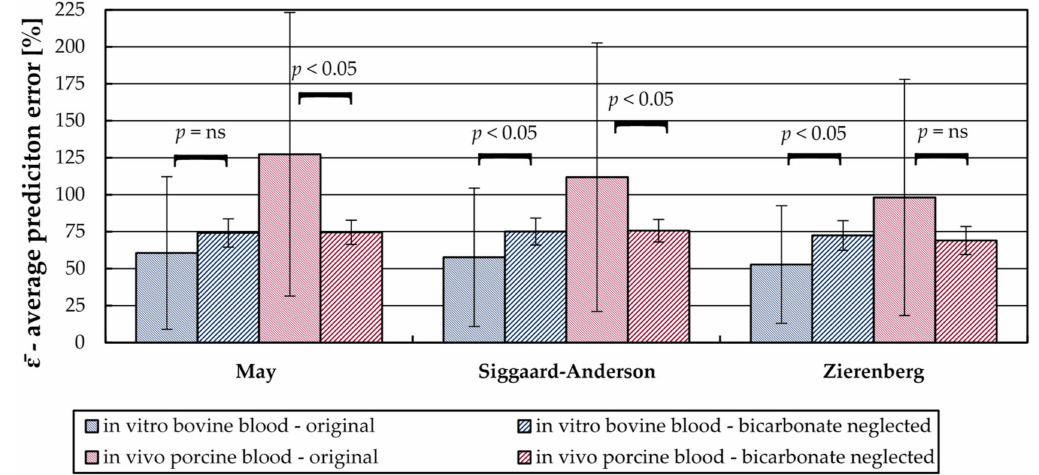
Figure 8. Average prediction error of the different solubility models when including (original) and neglecting the calculation of the bicarbonate content in blood. The error bars show the standard deviation. Difference of average prediction error between original model and model with neglected bicarbonate calculation was tested for significance with Welch’s t